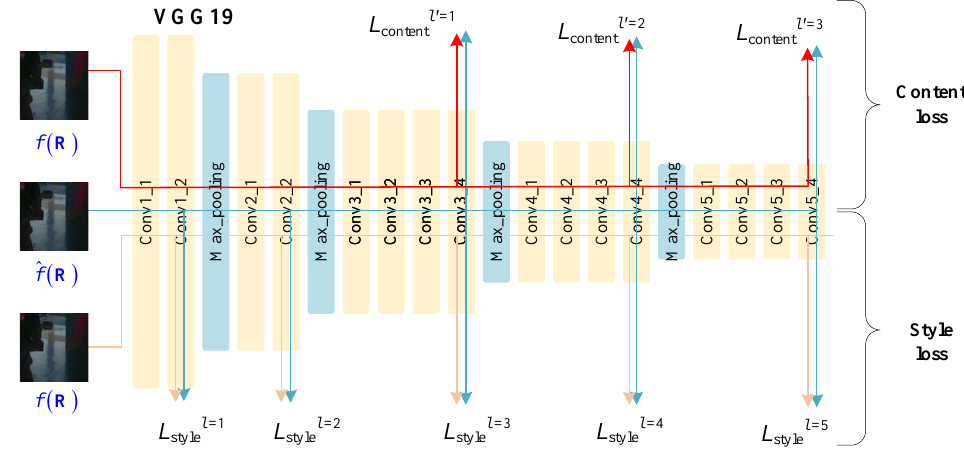
Figure 4. The framework of using contextual loss. The VGG19 network is used to optimize the content and style of the resulting